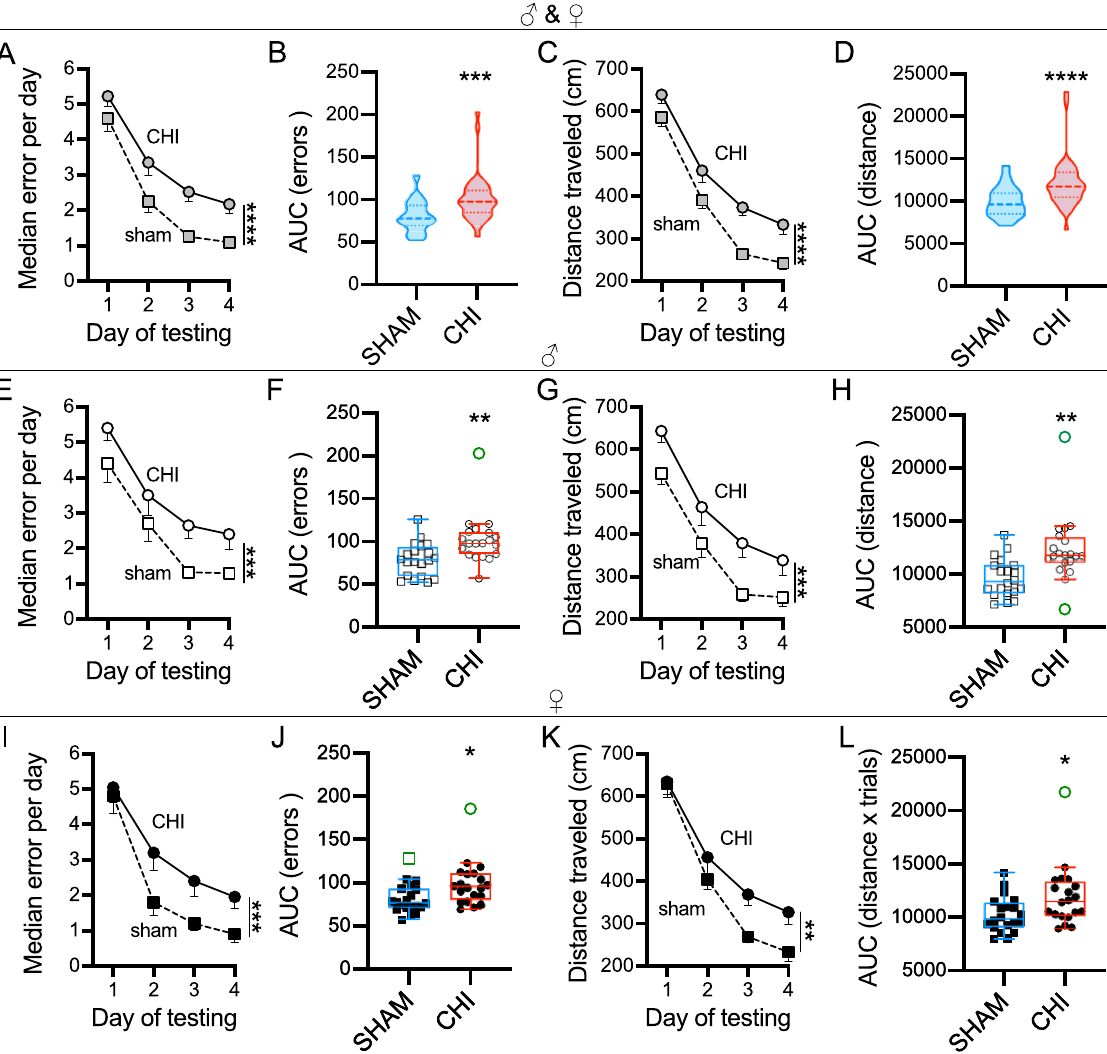
Fig 5. CHI induced memory deficits in RAWM at 2-week post-injury. Presented as males and females combined (first row), or males (second row) and females (third row) separately. While we found no statistical effect of sex, we nevertheless thought it important to disaggregate and report the data by sex. (A) CHI- and SHAM-operated mice were able to learn the RAWM task, but CHI mice made more errors compared to SHAM mice ( ���� p < 0.0001). (B) Area under the error curve confirmed that CHI mice were memory impaired ( ��� p = 0.0002). (C) Average distance travelled and (D) area under the distance curve show that CHI mice explored more than the SHAM group ( ���� p < 0.0001). Male mice following a CHI made more errors than the SHAM injured mice either by day ( E, ��� p = 0.0004) or for the AUC ( F, �� p = 0.0054). The trend held when data was plotted as distance traveled by day ( G, ���� p < 0.0001) or for the AUC ( H, �� p = 0.017). CHI was also found to cause worse performance in female mice for errors ( I, ��� p = 0.0005; J, � p = 0.016), and distance ( K, �� p = 0.0014; L � p = 0.026). Box-plot using Tukey method, with outliers shown in green. Sham (n = 40; 20/20 ♂ / ♀ ); CHI (n = 40; 20/20 ♂ / ♀ ).